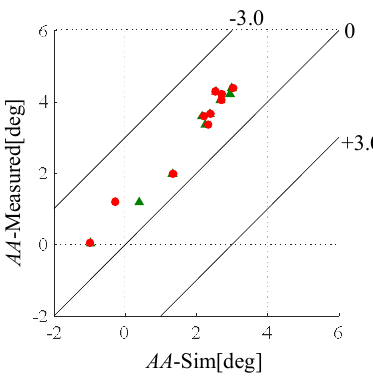
Figure 13. Comparison of measured and simulated results of AA . The triangle marks ( ▲ ) show the result without Head-torque, and the circle marks (●) show Head-torque.